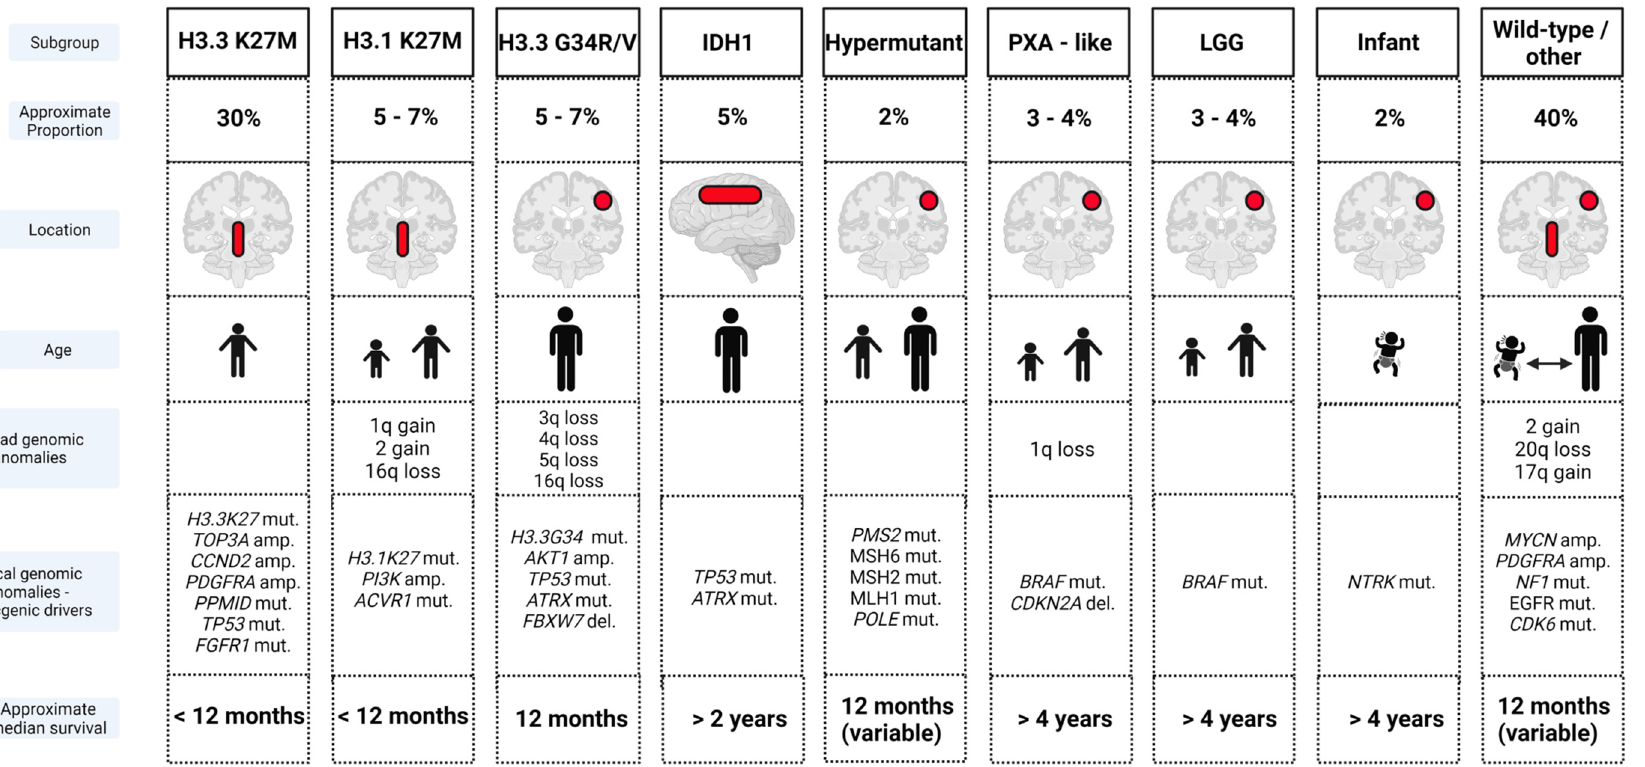
Figure 2: Molecular subgroups of pediatric high-grade glioma. At least nine subgroups are thought to exist, with biological and clinical features highlighted in accordance with [84,90,91]. Age-related cartoons depict infant, young child (2–5 years), child (5–12 years), and adolescent/adult (12+ years). Key: amp. = amplification, mut. = mutation, del. = deletion, actvn. = activation, IDH = isocitrate dehydrogenase, and PXA, pleomorphic xanthoastrocytoma.